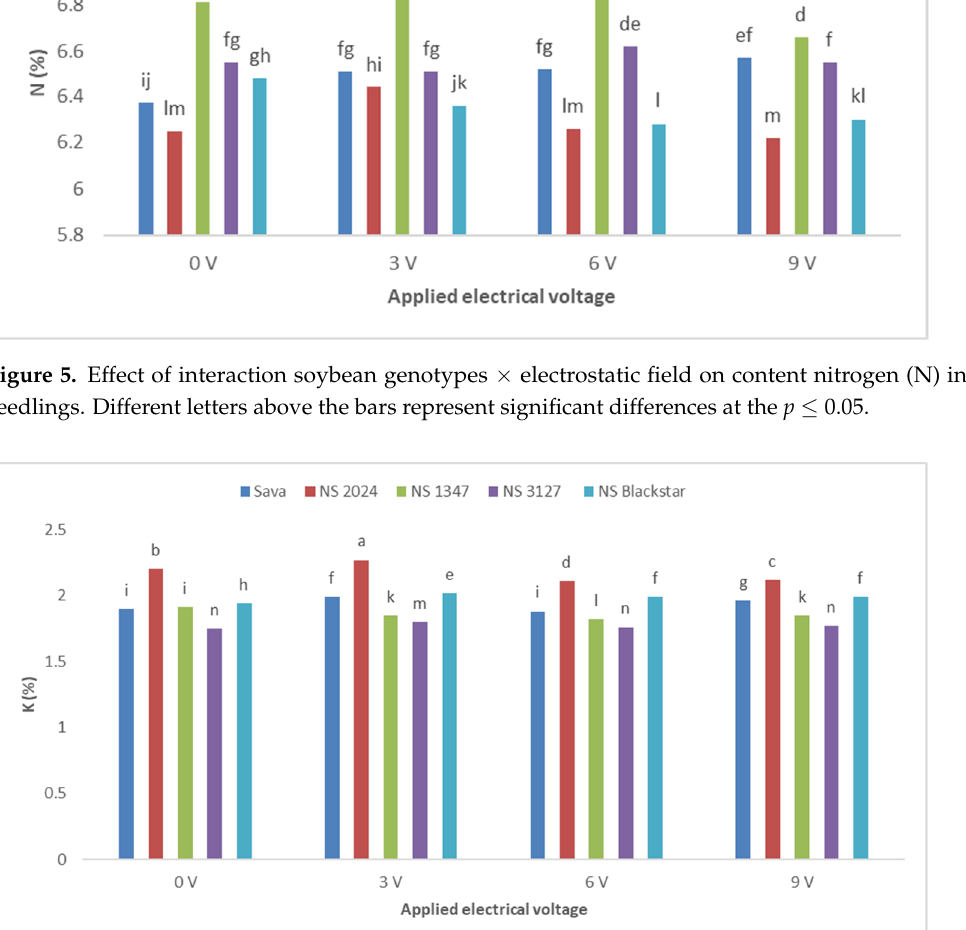
Figure 5. Effect of interaction soybean genotypes × electrostatic field on content nitrogen (N) in seedlings. Different letters above the bars represent significant differences at the p ≤ 0.05.